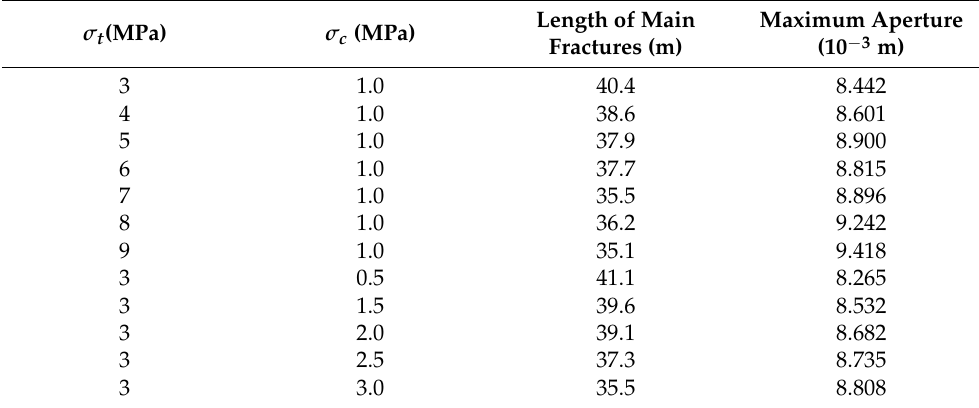
Figure 19. Fracture length under different cementing strengths of a natural fracture. Table 4. Fracture parameters under different tensile strengths of rock and cementing strengths of natural